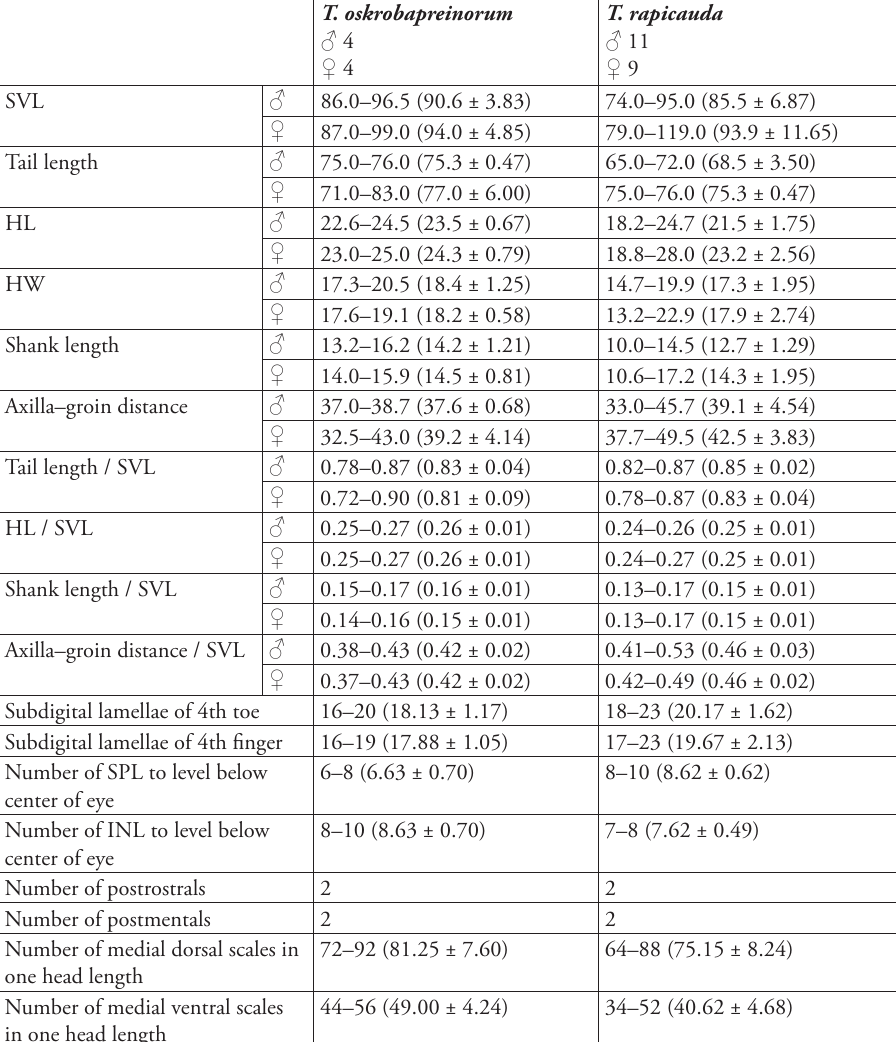
table 1. Selected measurements, proportions and scale characters of Thecadactylus oskrobapreinorum and T. rapicauda . Range is followed by mean value and standard deviation in parentheses. For abbreviations see text. For tail length, only complete original tails were